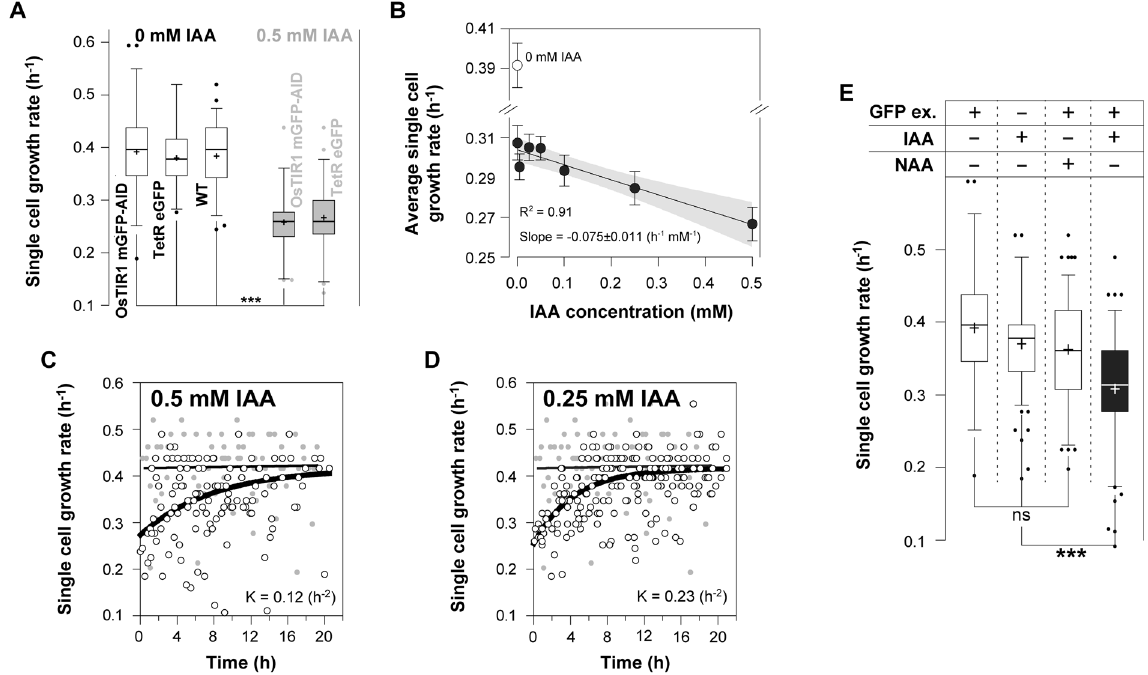
Figure 2. Auxin causes concentration-dependent and reversible growth defects, especially when combined with blue light for GFP excitation. ( A ) In order to measure potential effects of OsTIR1 or GFP expression on growth, we performed single cell experiments with cells expressing the plant F-box protein (YSBN6.G2J – Table S1), or eGFP via a tetracycline inducible system (YSBN6.C6B – Table S1), and measured their growth rates in the presence (grey boxes) and absence (white boxes) of auxin (error bars: 5–95 percentile, cross: mean). From left to right: 51 budding cycles from 37 single cells, 31 from 30, 50 from 9, 43 from 26 and 50 budding cycles from 19 single cells. The single cell growth rates (GR sc ) were estimated on the basis of the single cell doubling ln (2) time (DT sc ), or the time between two consecutive budding events = ( ) GR . The addition of 0.5 mM of sc DT sc auxin in the microfluidics device significantly slows down growth independently of the OsTIR1 expression (Kruskal-Wallis test, Dunns post-test to compare all pairs of data, p < 0.001 *** ). ( B ) The average growth rate of yeast was estimated in the presence of auxin at different concentrations, as well as in the absence of auxin on the single-cell level (error bars: SEM). From left to right: 54 budding cycles from 20 single cells, 57 from 27, 51 from 14, 50 from 16, 41 from 14, 51 from 19 and 50 budding cycles from 19 single cells. ( C , D ) Growth rate recovery after the removal of auxin (at 0 hours). One-phase exponential association functions were fitted to the recovering growth rates (K: rate constant). The plateau was set to the average growth rate of unperturbed wild type cells, grown for the same time in the microfluidic device (grey markers). A linear regression was fitted to the control data to illustrate unperturbed and steady state growth on high (10 gL − 1 ) glucose, in the microfluidic device. Data from ( C ) 195 budding cycles and 24 single cells, or ( D ) 126 budding cycles from 20 single cells are included. ( E ) The single cell growth rates of OsTIR1 expressing cells (error bars: 5–95 percentile, cross: mean), grown and monitored in the microfluidics, together with ( + ) or without ( − ) GFP excitation, with IAA (0.1 mM) or NAA (0.1 mM). From left to right: 51 budding cycles from 37 single cells, 117 from 39, 157 from 30 and 50 budding cycles from 16 single cells. IAA significantly reduces growth only in combination with GFP excitation (Kruskal-Wallis test, Dunns post-test to compare all pairs of data, p < 0.001 ***